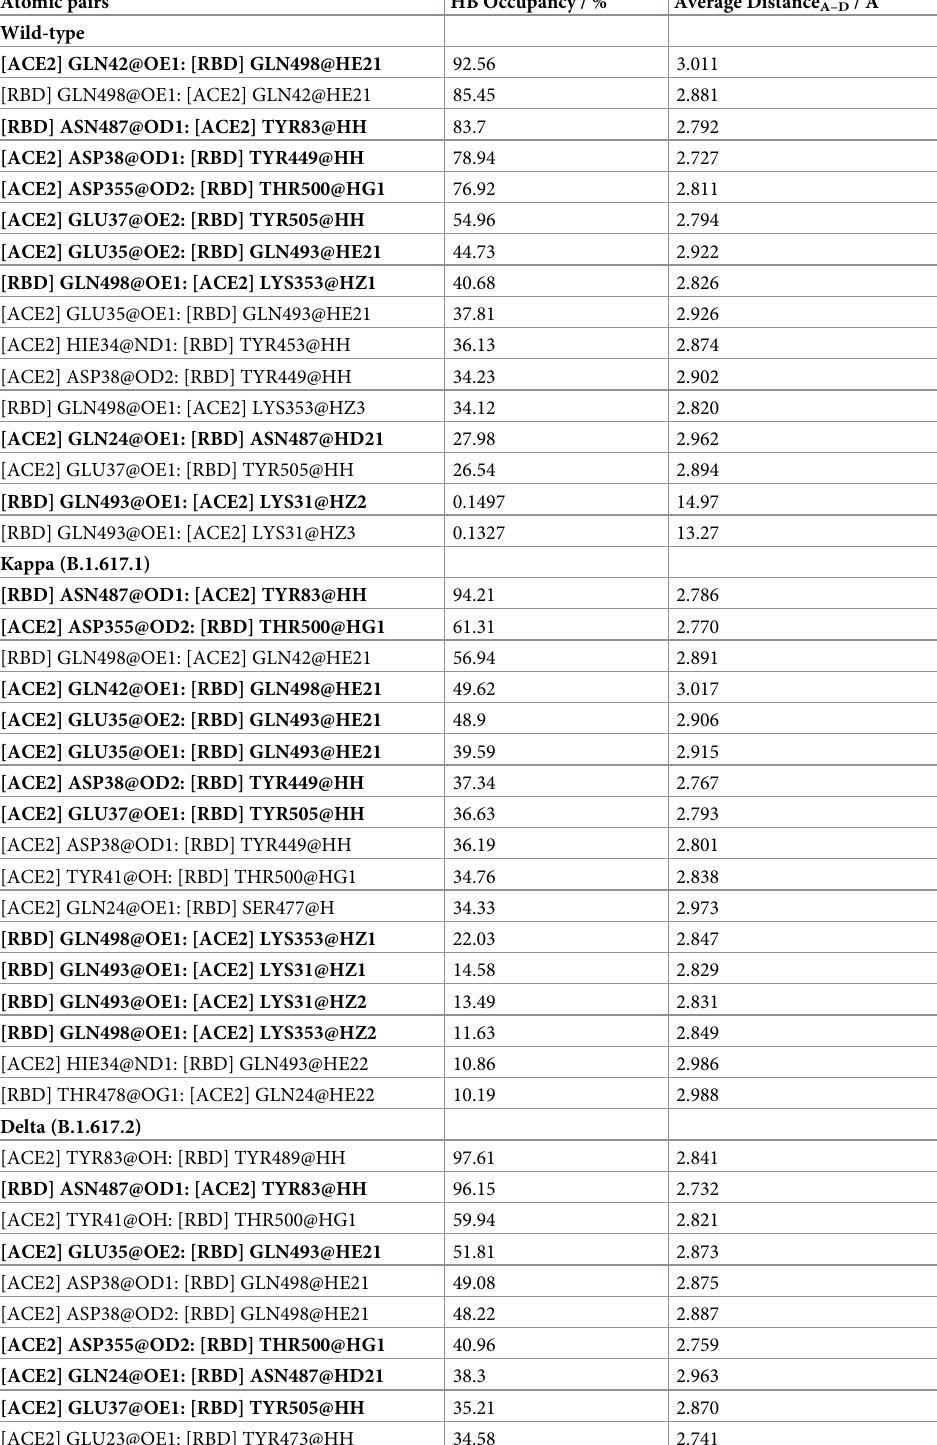
Table 2. Hydrogen bond occupancy for the residue pairs at the S-RBD binding interface with ACE2 (cut-off 3.5 Å ) over the production phase MD